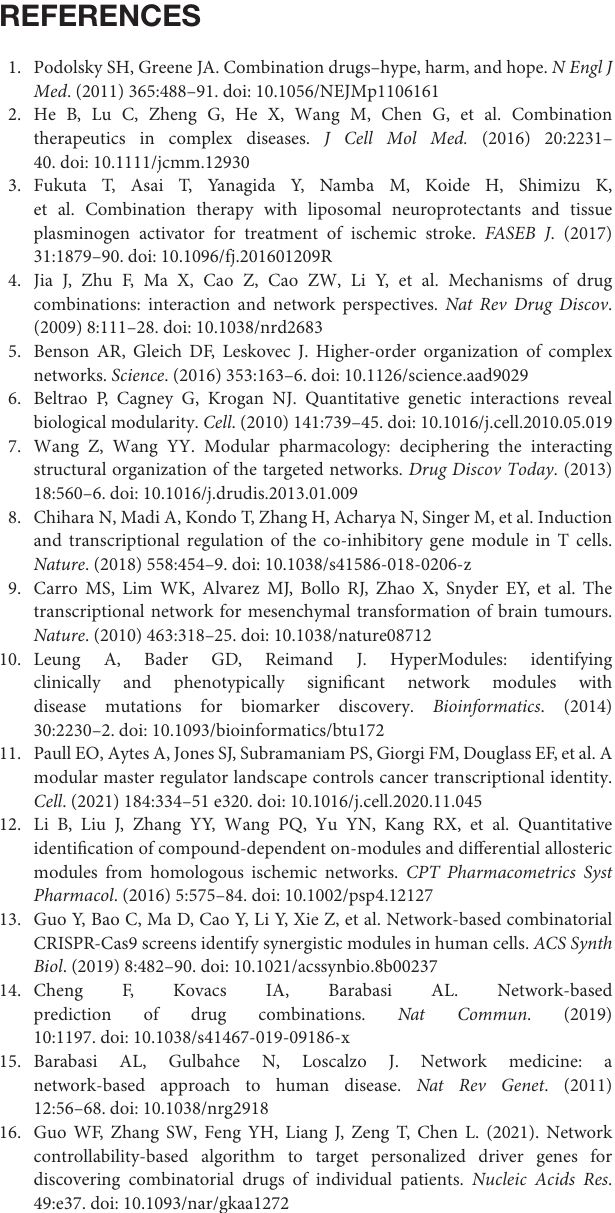
Supplementary Figure 2 | The uncropped images of the western blots presented in Figure 7 . Supplementary Figure 3 | The raw films of the western blots results. Supplementary Figure 4 | The network modules for the combined dataset across all the 3 groups. (A) The hierarchical cluster tree of the combined dataset, and modules are labeled with colors below the dendrogram. (B) The Z summary value of the 16 modules. Module with Z summary ≥ 2 indicates its preservation. The green and blue dotted lines indicate the boundary of strong and moderate preservation cutoff.